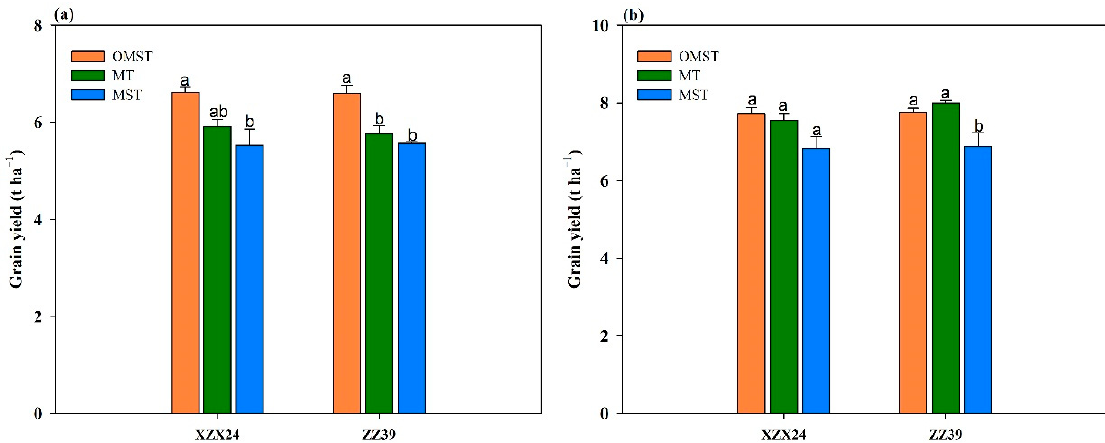
Figure 4. The rice grain yield under different rice establishment methods: ( a ) 2021; and ( b ) 2022. OMST: Orderly mechanical seedling throwing, MT: Manual transplanting, MST: Manual seedling throwing, XZX24: Xiangzaoxian24, ZZ39: Zhongzao39. Different lowercase letters denote statistical differences among treatments of a cultivar at the 5% level according to LSD test. Error bars above mean indicate standard error ( n = 3).